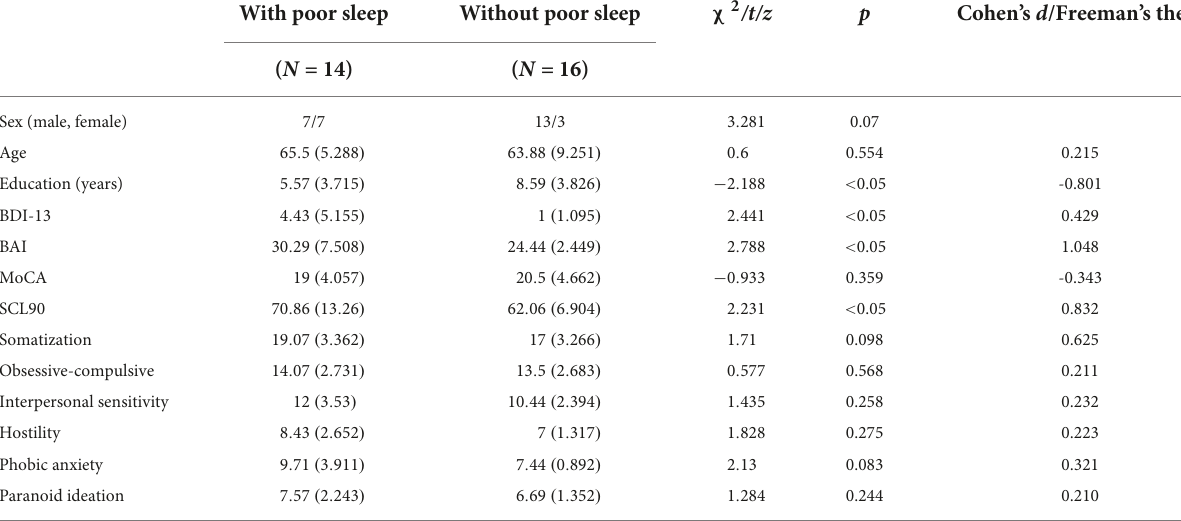
TABLE 2 Demographic and neuropsychiatric performance of patients with and without poor sleep quality.